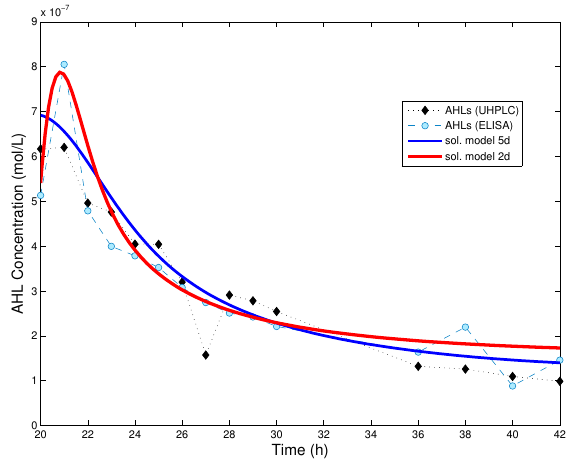
Figure 3. Comparison between the numerical solution of the dynamical systems and experimental data. Red curve: solution of the reduced system (8); Blue curve: solution of the full model (4) in [18]. Initial data for the reduced system are x ( t ) = x 0 ( t ) , y ( t ) = y 0 ( t ) , t ∈ [ 18,20 ] , where y 0 ( t ) ≡ 5.2 × 10 − 13 was fitted and x 0 ( t ) ≡ 5.4044 × 10 − 7 is the mean value of ELISA and UHPLC measurements at 19 h from the beginning of the experiment. When the cell population has reached its stationary level, the reduced model provides a good approximation of the dynamics. Parameter values used for the reduced model are given in Table